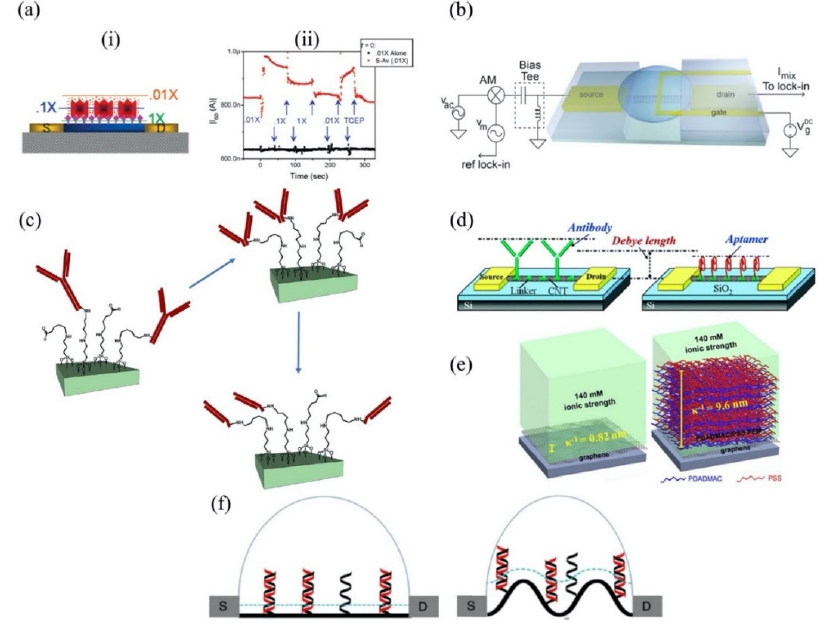
Figure 3 . FET biosensors methodologies to overcome screening limitation ( a ‐ i ) Debye length ( λ D ) model in different ionic strength by Stern et al. The Debye length in 1 × PBS, 0.1 × PBS and 0.01 × PBS represent by the green line, blue line and orange line, respectively. ( a ‐ ii ) The response of the biotin ‐ functionalized FET for streptavidin detection in different ionic strength. Reprinted (adapted) with permission from [41]. Copyright 2007 American Chemical Society. ( b ) Geometry of a FET sensor device with mixing current measurement setup for high ‐ frequency sensor device operation. Reprinted